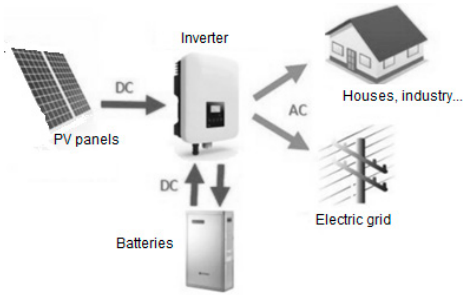
Figure 16. Battery connected to a hybrid inverter scheme.